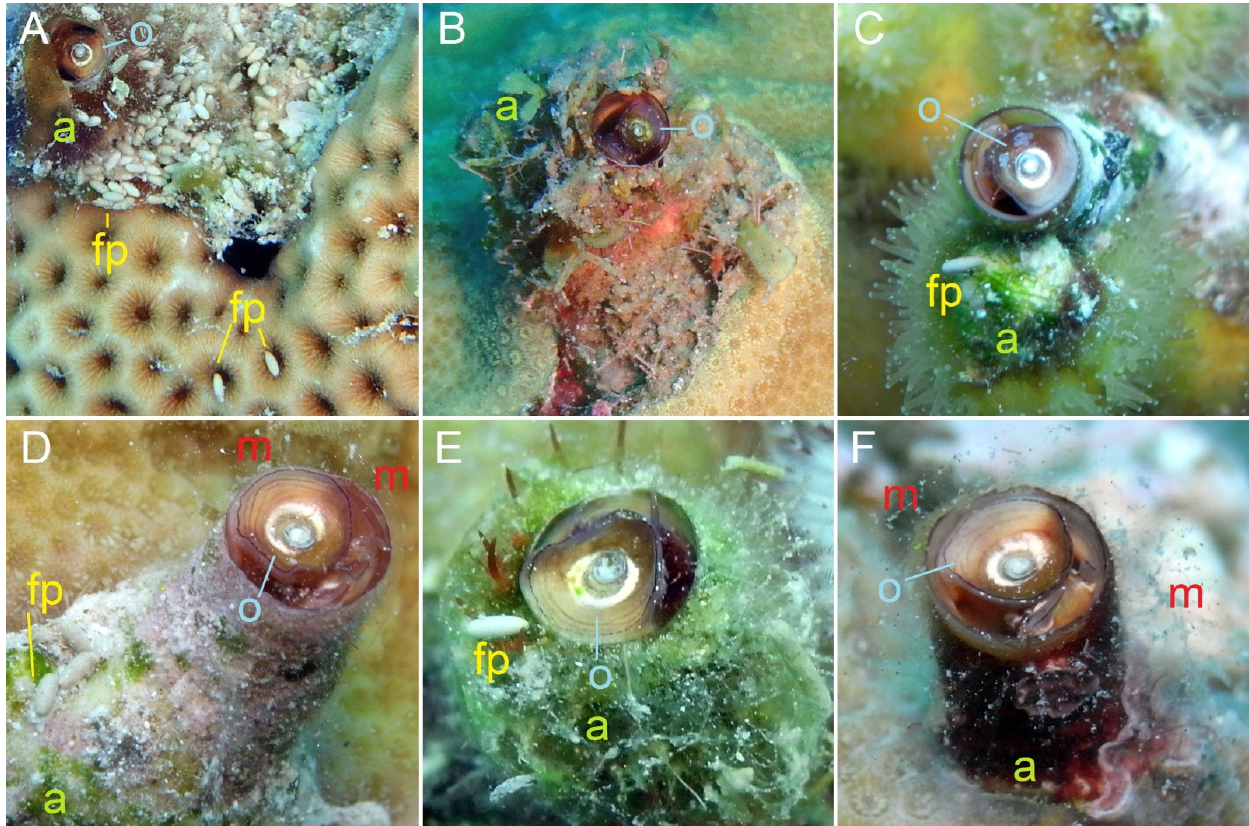
Figure 3. Close-up images of worm snails ( Petaloconchus sp.) and their hosts: Siderastrea siderea ( A ), Porites astreoides ( B , D – F ), and Madracis auretenra ( C ). The tubes are partly or entirely overgrown or surrounded by green and red algae (a). The operculum (o) appears to be tapering towards one side because of the margins being turned upwards next to the tentacles. Some worms show remnants of mucus nets (m). Faecal pellets are common around the tubes (fp). Tube diame- ter: ca. 4